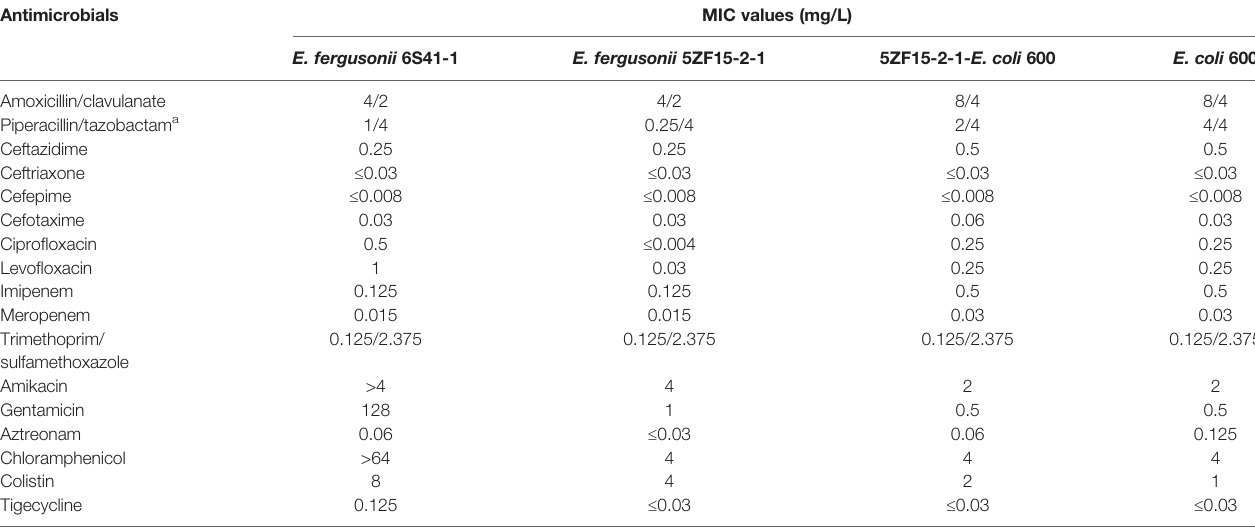
TABLE 1 | MIC values of antimicrobials for E. fergusonii 6S41-1, 5ZF15-2-1, transconjugant 5ZF15-2-1- E. coli 600 and recipient strain E. coli 600. Antimicrobials